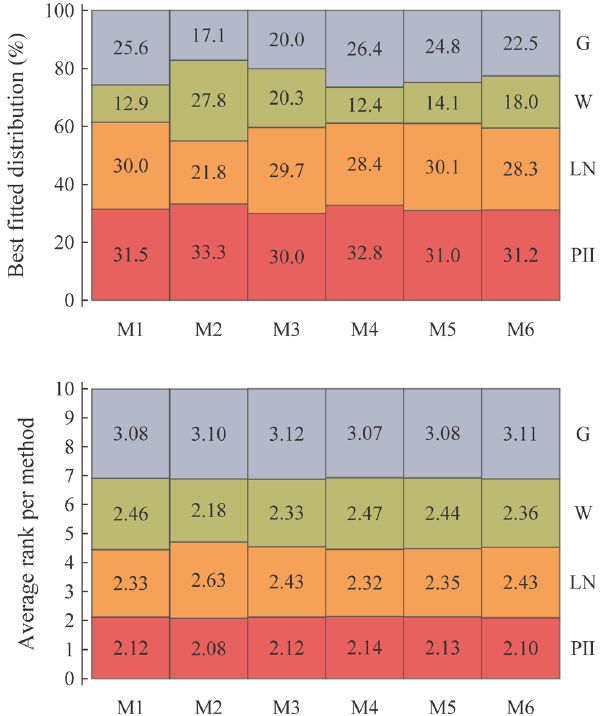
Fig. 10. Performance results of the four fitted tails in 2000 randomly selected records using six different methods for selecting the sample size: (top panel) percentage of records in which each distribution tail was best fitted; (bottom panel) average ranks of the fitted tails (lower average rank indicates better